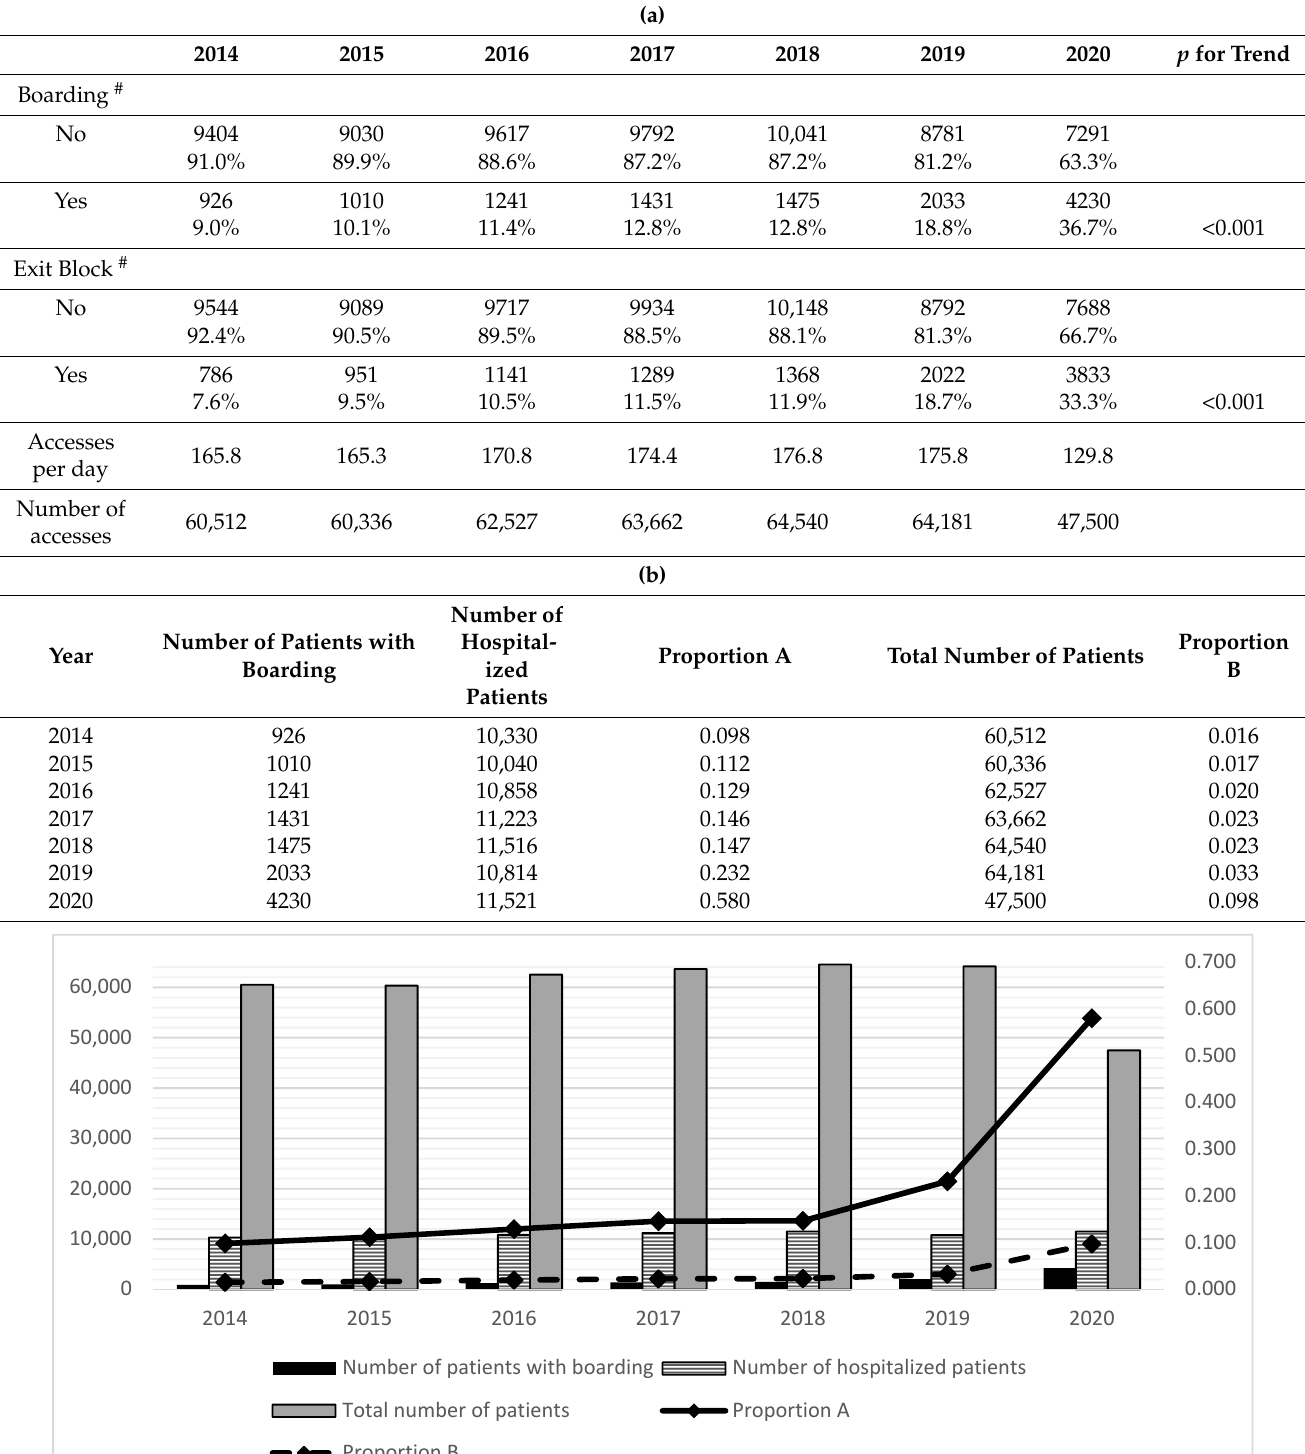
Number of hospitalized